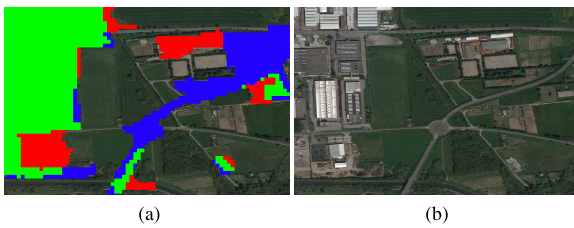
Figure 8: Classification error example. (a) Classification results, using both stacks. (b) reference Google earth